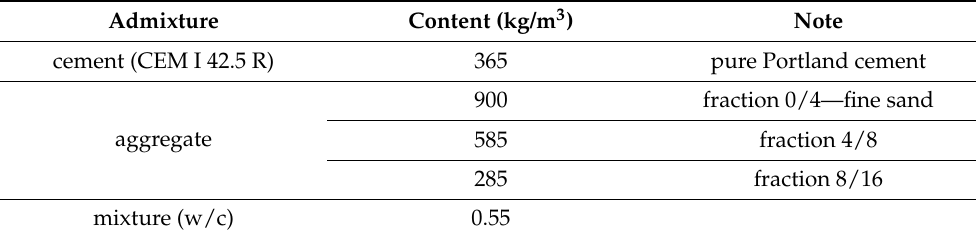
Table 3. Content by m 3 of concrete cubic samples for compressive strength measuring.